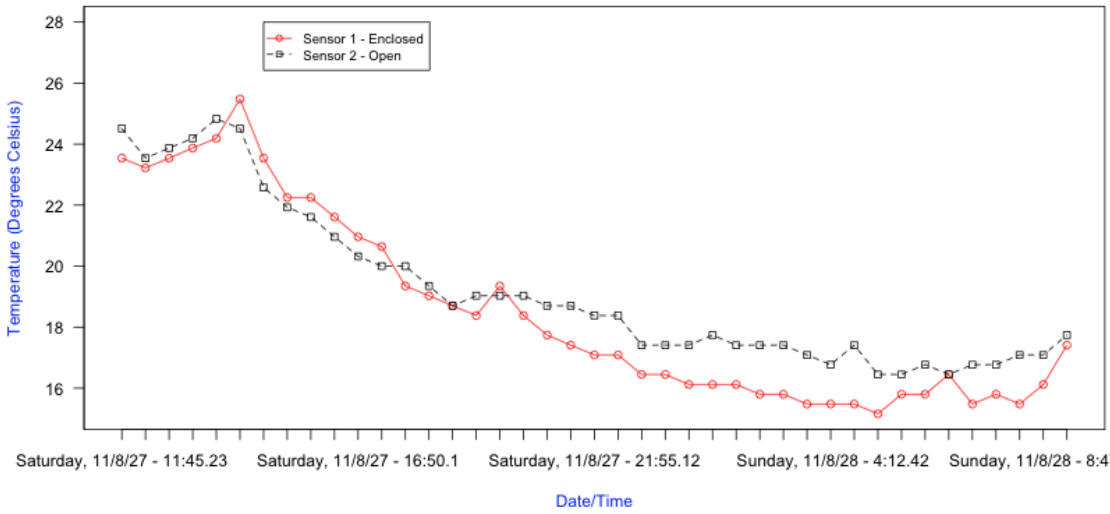
Figure 11. Behavior of temperature sensors in and outside of Perspex